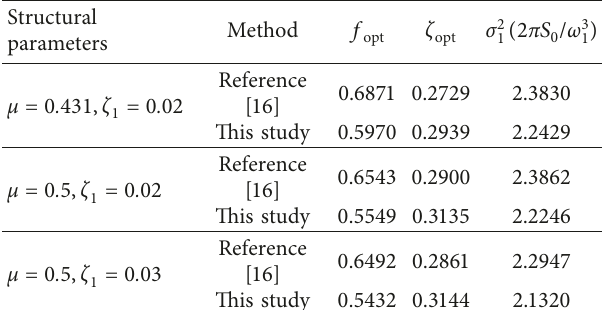
Figure 8: The error rate of the revised fitting formula value with the TMD mass ratio and the damping ratio of the main structure under stationary white noise excitations. (a) Error rate of the frequency ratio. (b) Error rate of the damping Table 1: Optimal design of large mass ratio TMD according to reference [16] and this study.